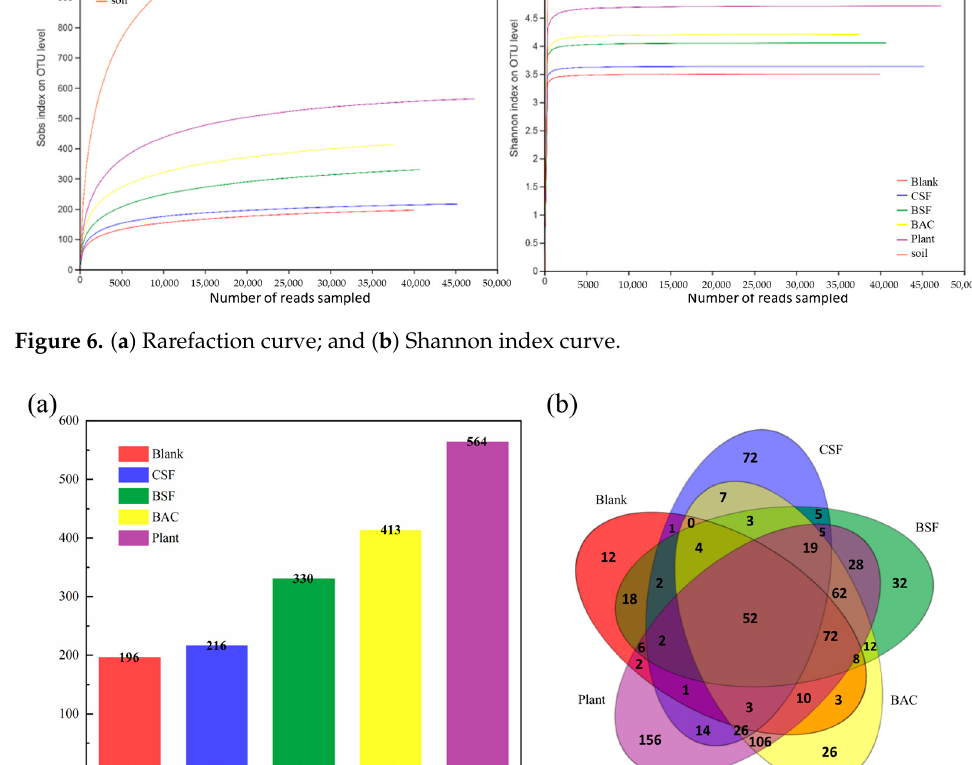
Figure 7. ( a ) Distribution diagram of OTU number; and ( b ) Venn diagram.